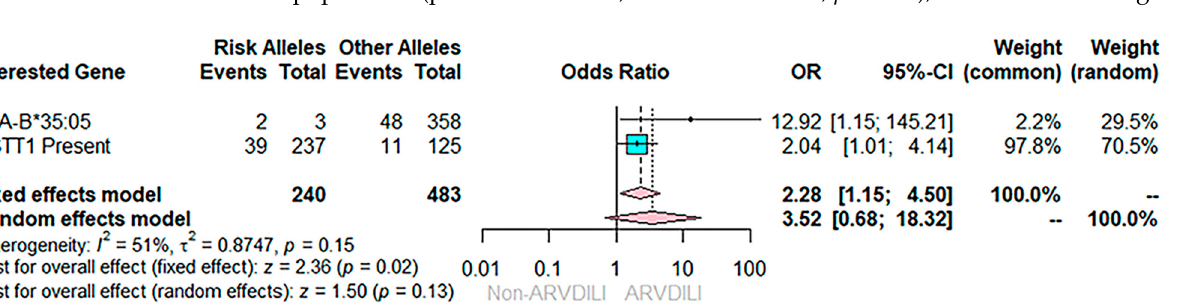
Figure 2. Effects of GSTT1 and HLA-B*35:05 gene polymorphisms on ARVDILI combination using a fixed-effect model of Mantel–Haenszel statistics. The cyan squares and lines represents the point estimate of the odd ratio and 95% confidence intervals, while the pink diamonds represents the overall effect of all studies using the fixed and random effect models, respectively.